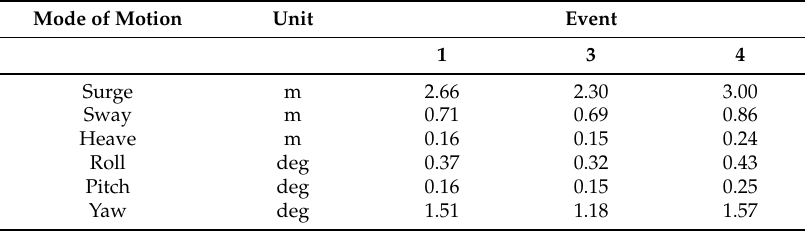
Table 3. Significant peak-to-peak vessel motions for the Base